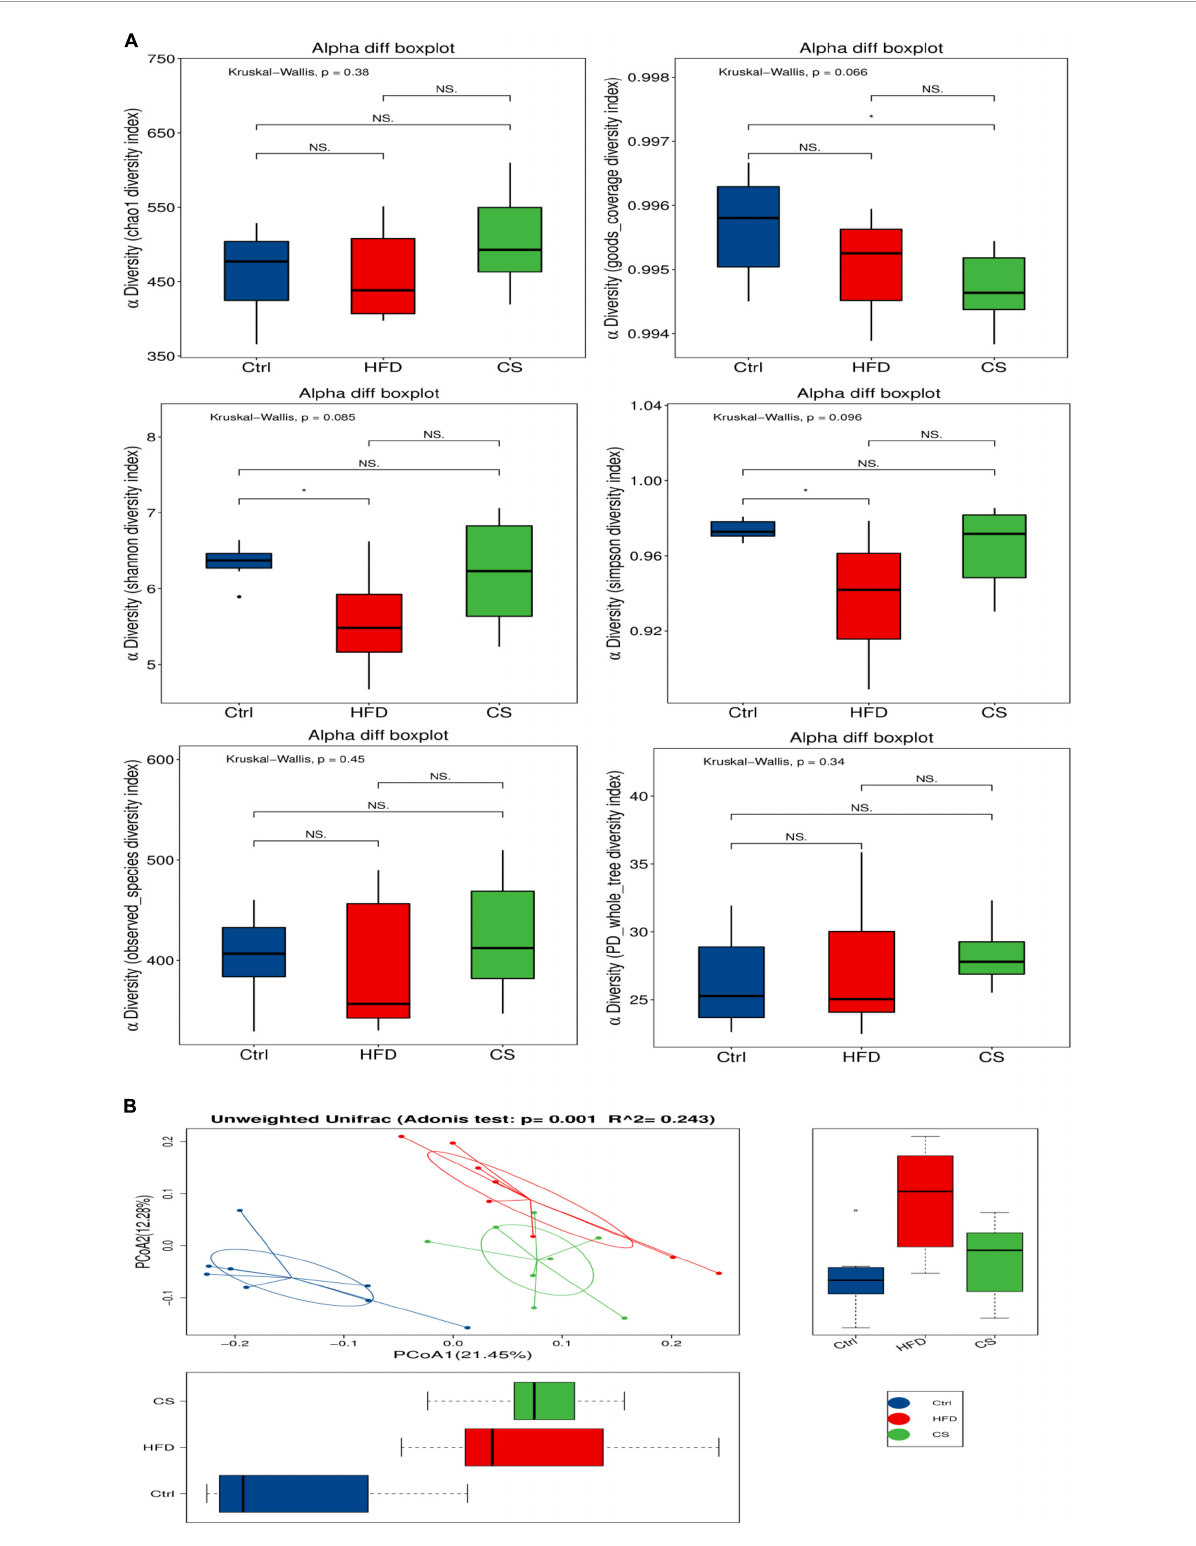
FIGURE6 Effects of corn silk extract on the α - diversity and β - diversity index of gut microbiota in mice. (A) α -Diversity; (B) unweighted UniFrac PCoA analysis. Control diet (Ctrl) group, high- fat diet (HFD) group, corn silk (CS) group. The results are means ± SD ( n = 8). * p < 0.05 vs. other group. ns, not